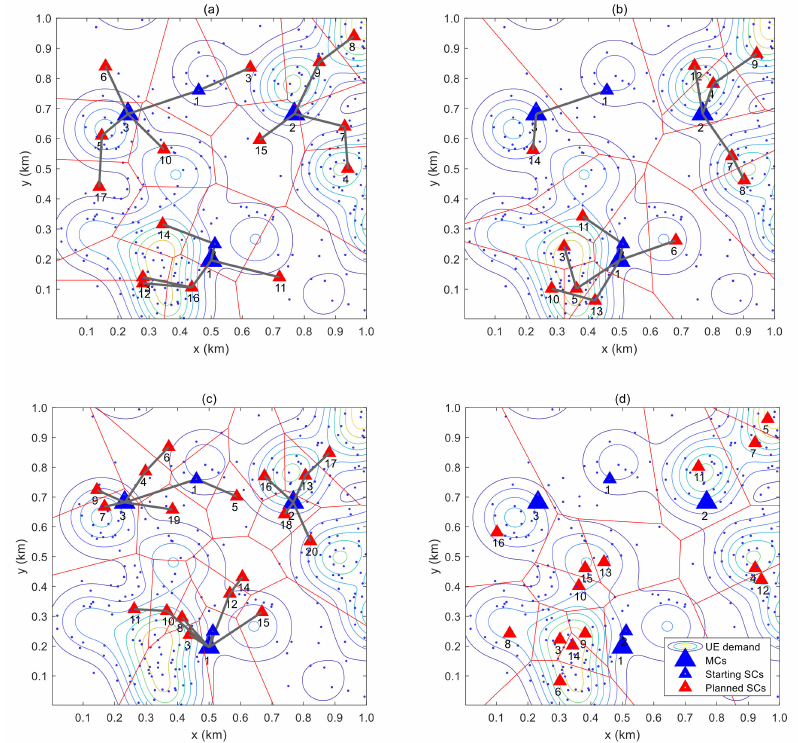
Figure 1. Example network deployment for a tra ffi c demand of 5 Gbps in the overall area for each evaluated algorithm. ( a ) CEBA method; ( b ) ESBA method; ( c ) RSBA method; ( d ) ESIB